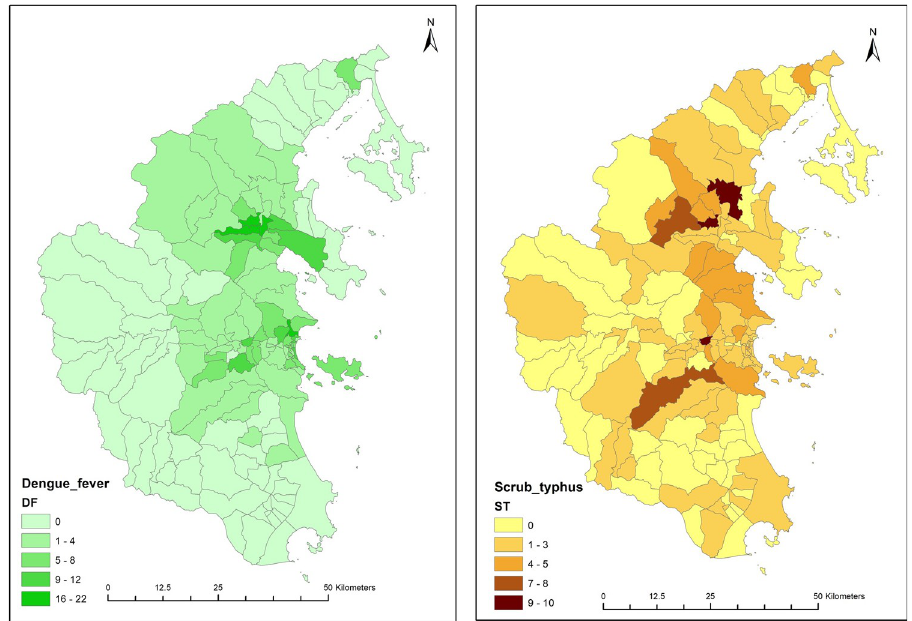
Fig 2. The geographic distribution in Khanh Hoa of all scrub typhus (n = 221) and dengue fever (n = 387) confirmed cases in this study is depicted in these maps. (note: this figure was created using ArcGIS 1 software by Esri (www.esri.com). Source of the administrative layer of Vietnam was obtained from the website (http://www.diva- gis.org/datadown#google_vignette) which is free for community